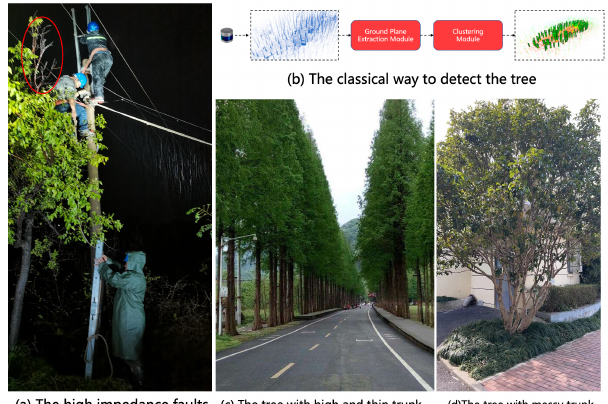
Figure 1. The figure(a) shows the HIF caused by the towering tree. The figure(b) shows classical pipeline of tree detection, the high and think trunk showed in figure(c) is more suitable for the clustering algorithm and the messy trunk in figure(d) always brought to the failure detection.